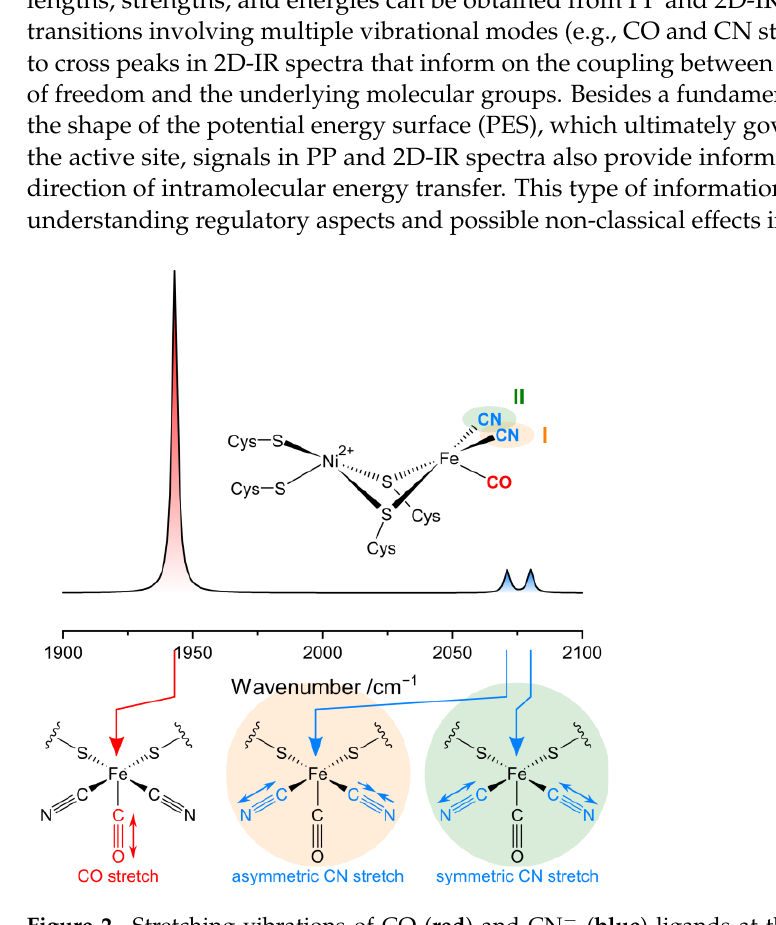
Figure 2. Stretching vibrations of CO ( red ) and CN − ( blue ) ligands at the active site of [NiFe] hydrogenase and associated fundamental transitions in the IR absorption spectrum, exemplarily shown for the Ni a - S state (spectrum simulated from experimental transition frequencies of Re RH). Partial localization of symmetric and antisymmetric νCN vibrations to cyanide ligands I and II is indicated by orange and green shading, respectively.